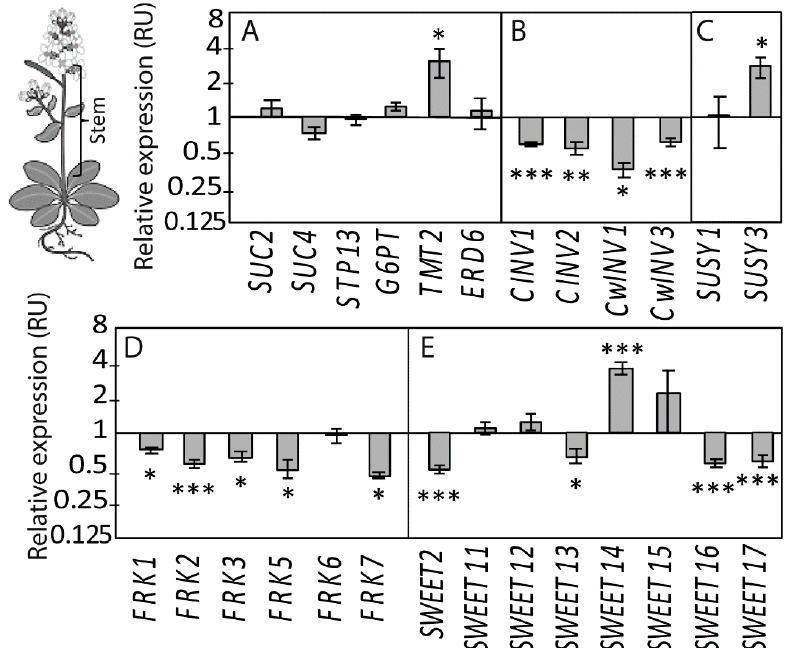
Figure 4. Relative expression of candidate genes in the stem under high salinity in the stem of Ctrl and SStr plants at 13 DABS. For each gene, bar plots showed the mean accumulation of transcripts ± SE ( n = 5–6) normalized by the mean value of Ctrl plants, with Ctrl plants on the left side (black bars) and SStr plants on the right side (grey bars). ( A – E ) Relative expression of genes coding for ( A ) disaccharide and monosaccharide transporters ( SUC2 , SUC4 , STP13 , G6PT , TMT2 , ERD6 ), ( B ) cytosolic and cell wall invertases ( CINV1 , CINV2 , CwINV1 , CwINV3 ), ( C ) sucrose synthases ( SUSY1 and SUSY3 ), ( D ) fructokinases ( FRK1 , 2 , 3 , 5 , 6 and 7 ), and ( E ) SWEET sugar transporters ( SWEET2 , 11 , 12 , 13 , 14 , 15 , 16 , 17 ). Asterisks indicate significant difference of treatments compared to control plants (* p < 0.05; ** p < 0.01; *** p < 0.001).